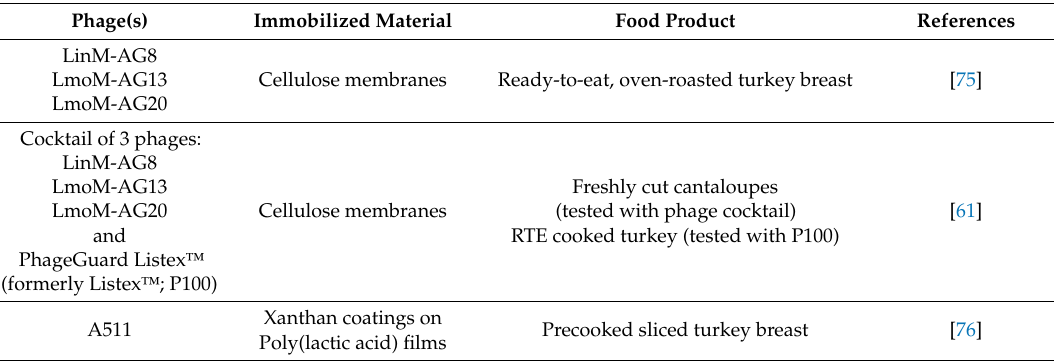
Table 2. Summarized attempts of immobilizing antilisterial